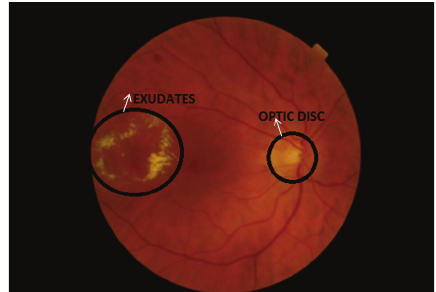
Figure 4: Fundus image with